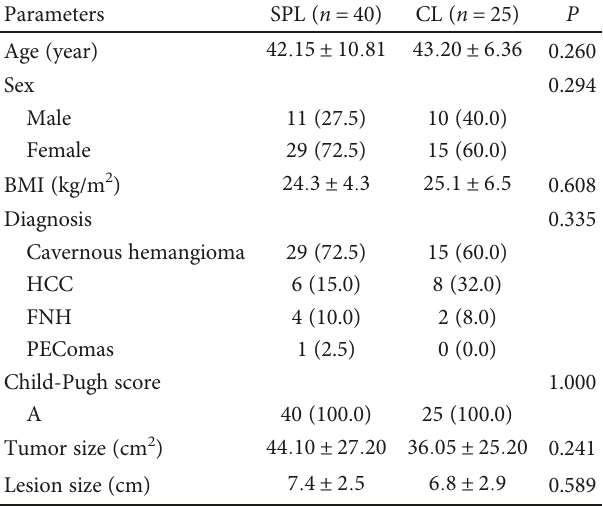
Table 1: Patient ’ s demographic and clinical